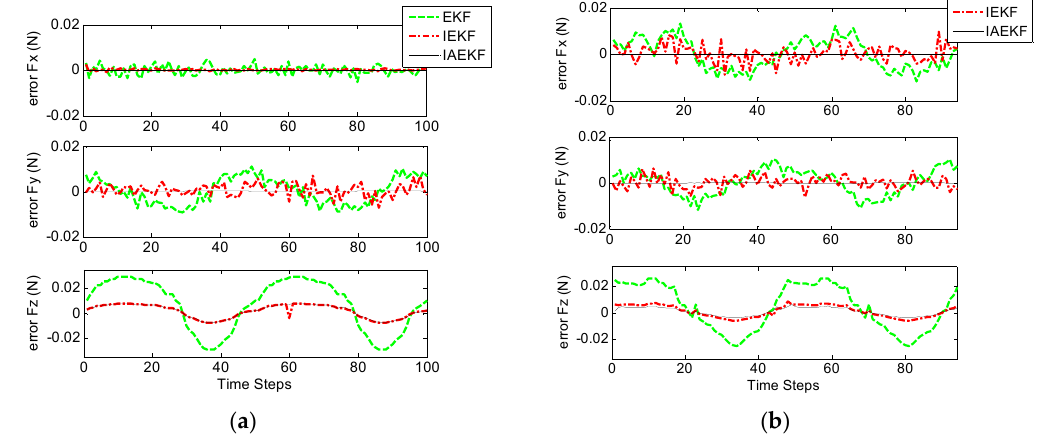
Figure 10. Estimation errors of contact forces applied to the catheter tip: ( a ) k 1,0 “ 39.99 m ´ 1 , and quasi-sinusoidal planar tip force; ( b ) k 1,0 “ 24.57 m ´ 1 , and quasi-sinusoidal spatial force. Table 7. Average force estimation errors (N) for EKF, IEKF and IAEKF in experiments. Experiment I (a)